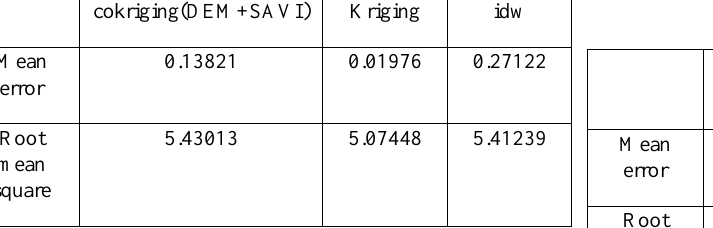
Table 3. Cokriging(DEM+SAVI), Kriging, IDW Accuracy